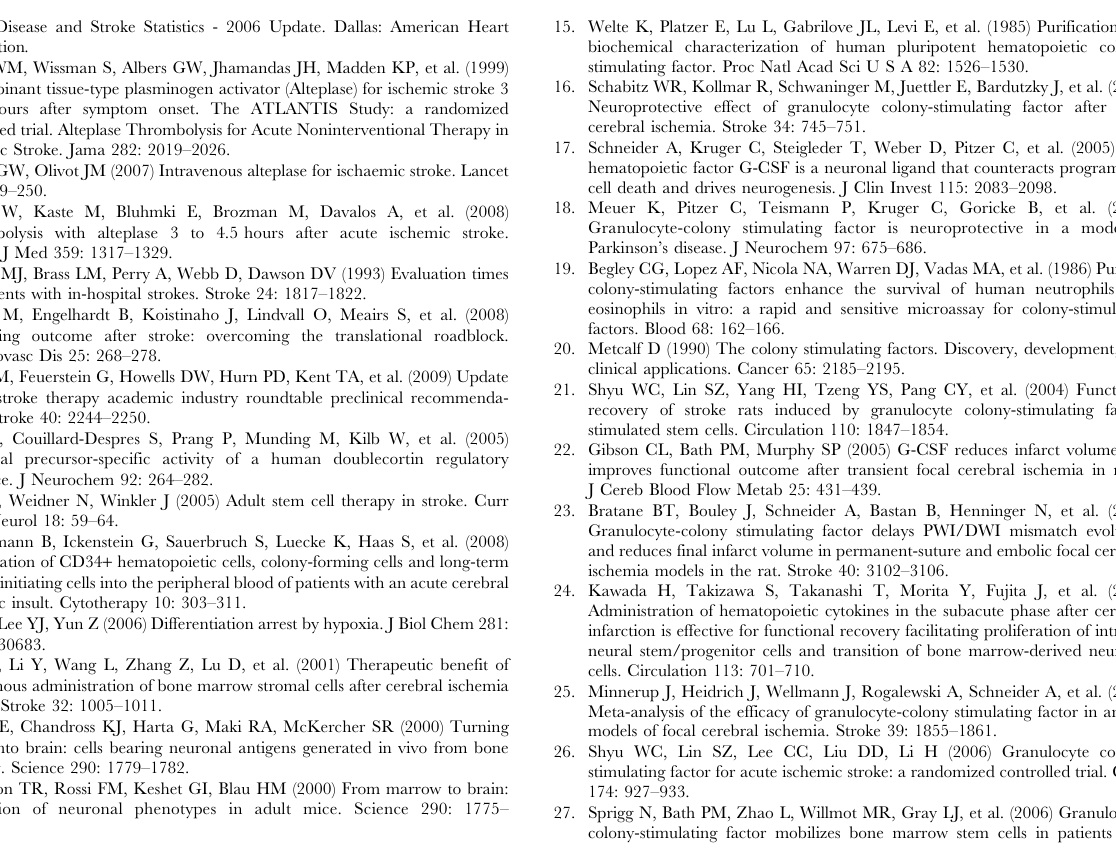
Figure S1 CRP (c-reactive protein) in mg/dl over time as median with minimum and maximum in the three different dosage groups. Figure S2 Leukocytes/ m l over time as median with minimum and maximum in the three different dosage groups. Table S1 Patients included in the VGM analysis. The table shows the 8 individuals’ gender and age and the timing of sequential MRIs after stroke onset (first to third MRI in days, fourth MRI in months).